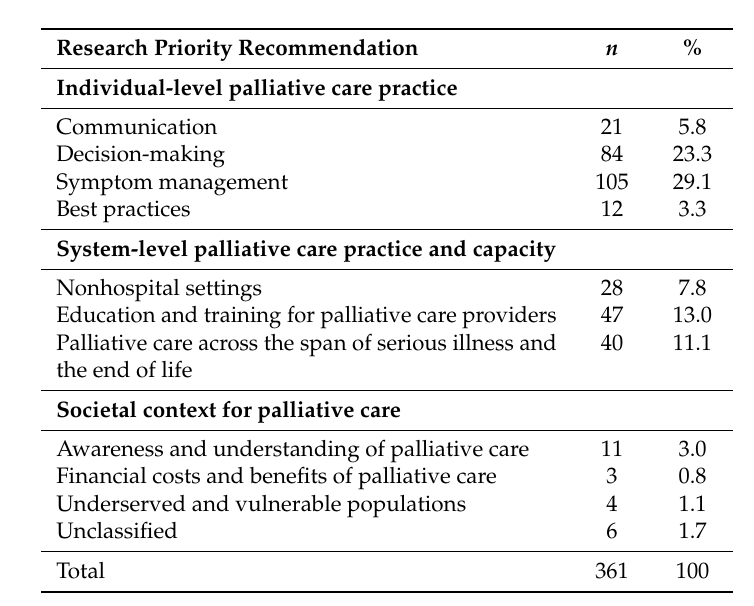
Table 9. Distribution of scientific production by research priority recommendation ( n and